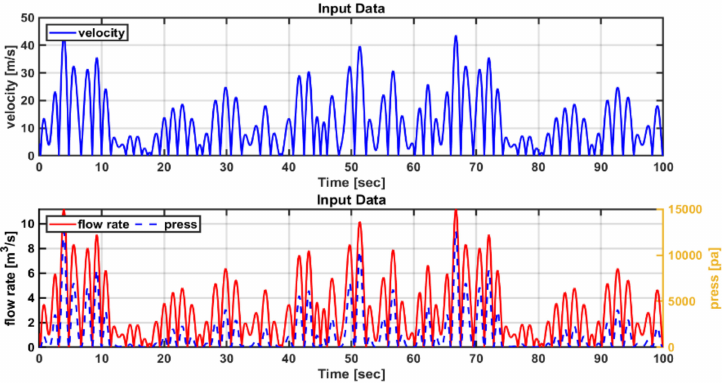
Figure 25. Water level in the OWC chamber, turbine flow rate, and turbine flow rate and pressure in irregular wave ( v t = 0~42 m / s and Tp = 4.75 s) input